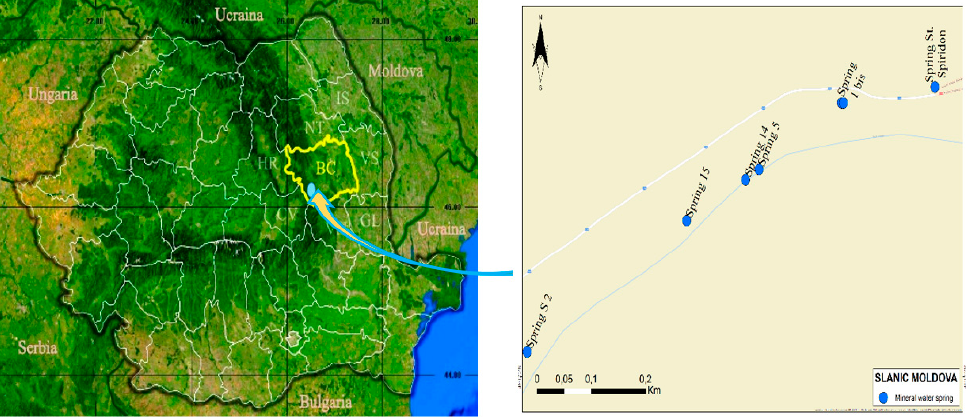
Figure 1. Position of the selected mineral water sampling points from Slanic Moldova, Bacau County (Romania).